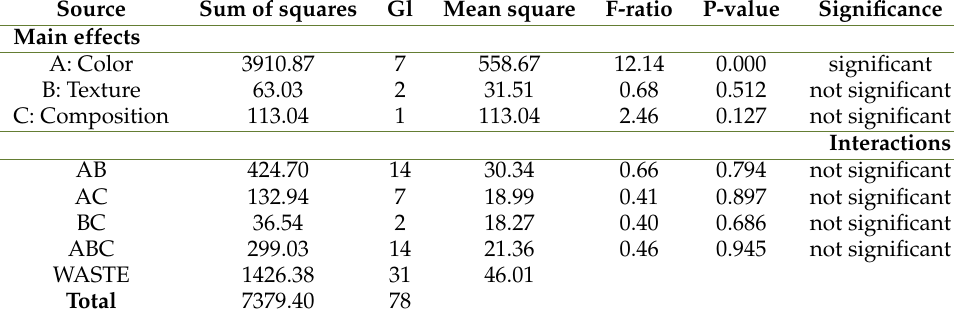
Table 3. Analysis of Variance for SRI 3 . Sources: Author’s own work.